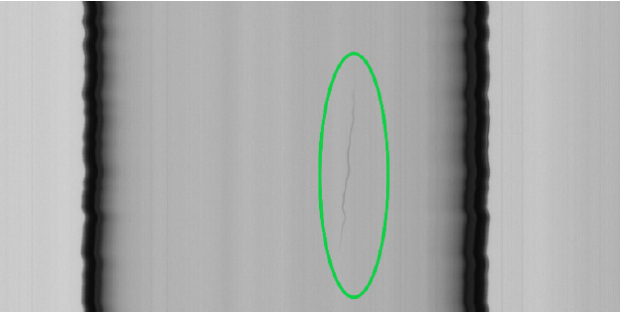
Figure 3. An air line defect (enclosed in a green oval). Due to the rotations and oscillations of the tube, the air line appears curved and irregular in the image, although it is straight. tube, the air line appears curved and irregular in the image, although it is